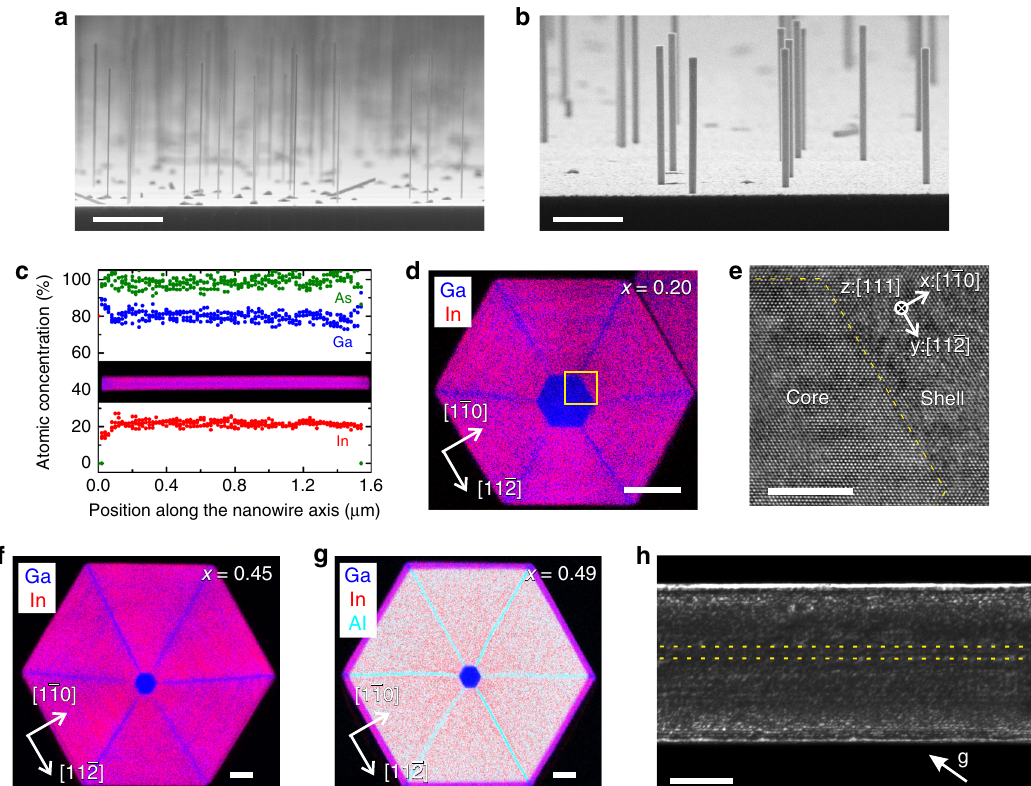
Fig. 1 Morphological, compositional and structural analysis of GaAs/In x Ga 1 − x As and GaAs/In x Al 1 − x As core/shell nanowires grown on Si(111) substrates. a Side-view scanning electron microscopy (SEM) image of as-grown bare GaAs core nanowires and ( b ) GaAs/In x Ga 1 − x As core/shell nanowires ( x = 0.20, shell thickness L S = 40 nm). c Energy-dispersive X-ray spectroscopy (EDXS) compositional analysis of the shell along the axis of one nanowire from the sample shown in ( b ). The zero position corresponds to the tip of the nanowire. The inset depicts the corresponding compositional map. d EDXS compositional map perpendicular to the axis of one nanowire from the sample shown in ( b ). e High-resolution transmission electron microscopy (TEM) micrograph of the core/shell interface region shown in ( d ) with a yellow square. The dotted line indicates the core/shell interface. The 1 (cid:1) 10 ½ (cid:2) , 11 (cid:1) 2 crystallographic directions are indicated as x -, y - and z - axes, respectively. f EDXS compositional map perpendicular to the axis of a GaAs/In x Ga 1 − x As core/ shell nanowire with x = 0.45 and L S = 80 nm. g EDXS compositional map perpendicular to the axis of a GaAs/In x Al 1 − x As core/shell nanowire with x = 0.49 and L S = 80 nm. h (220) weak-beam dark- fi eld TEM image of a GaAs/In x Al 1 − x As nanowire like in ( g ) that shows no mis fi t dislocations in the region of the core (between the yellow dotted lines). The scale bars correspond to 1 μ m in ( a , b ), 30 nm in ( d , f , g ), 5 nm in ( e ), and 100 nm in ( h